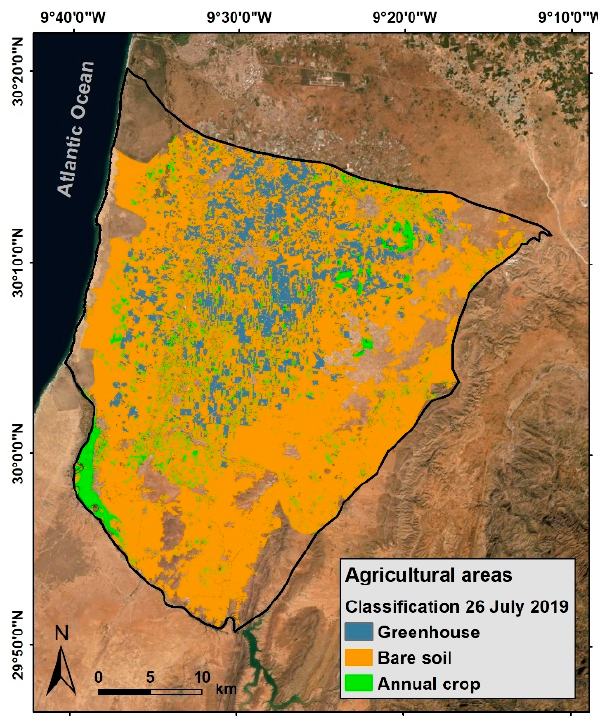
Figure 2. Map of classification results for summer 2019.